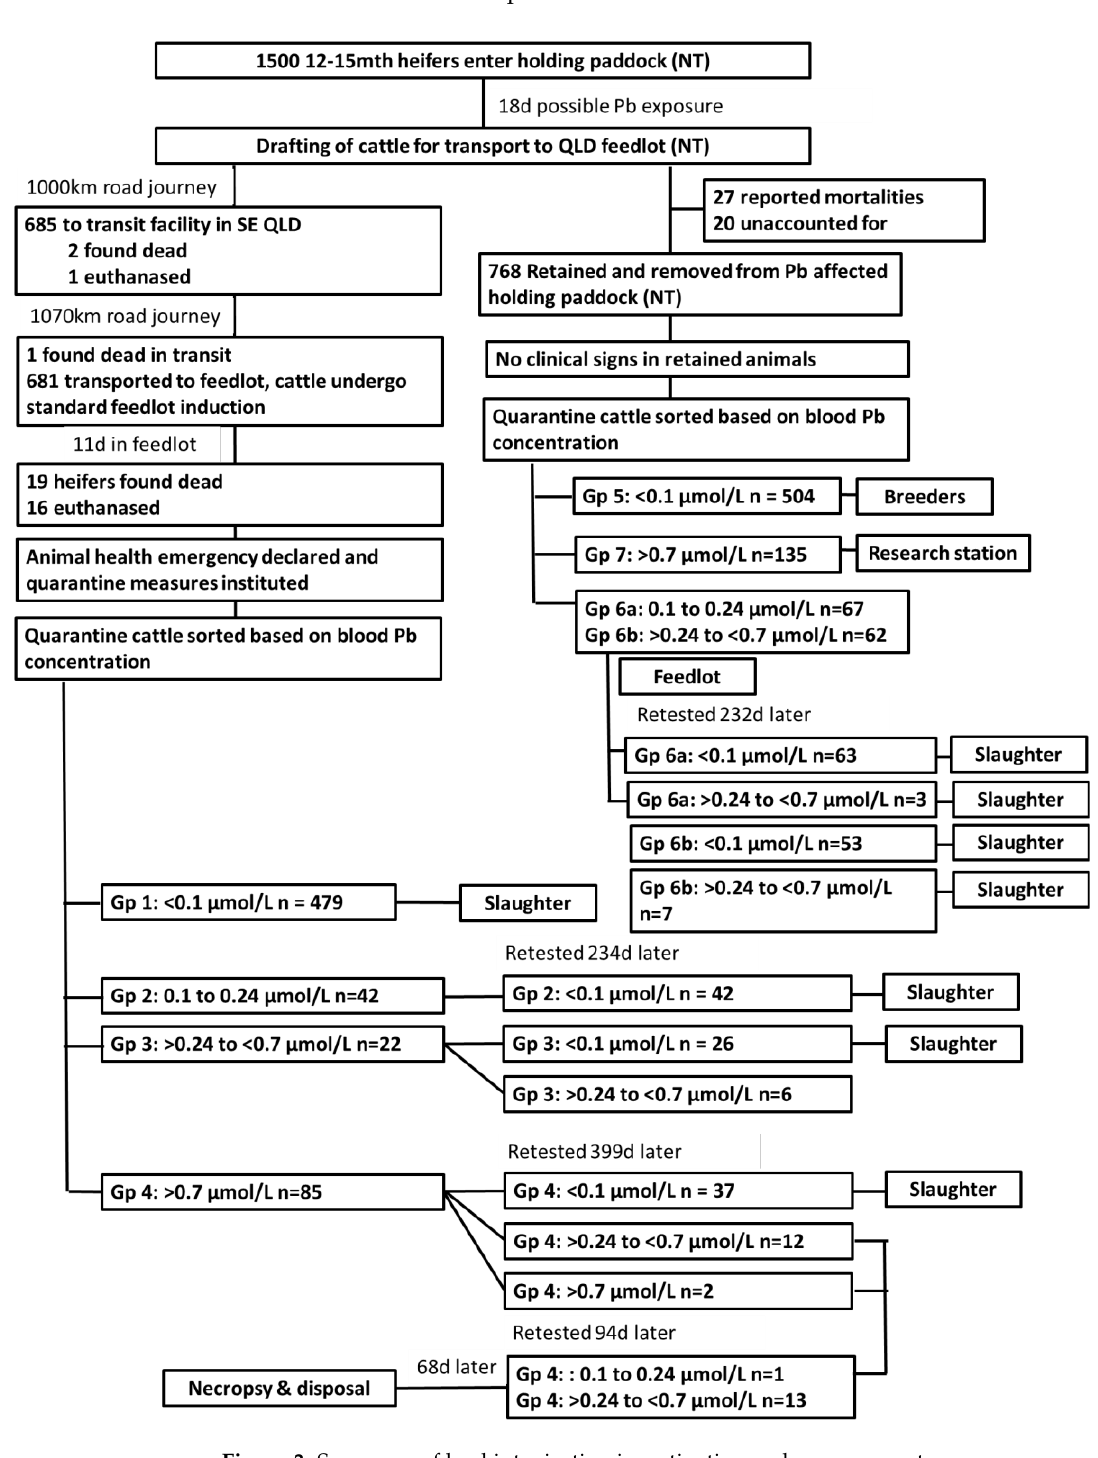
Figure 3. Summary of lead intoxication investigation and management.